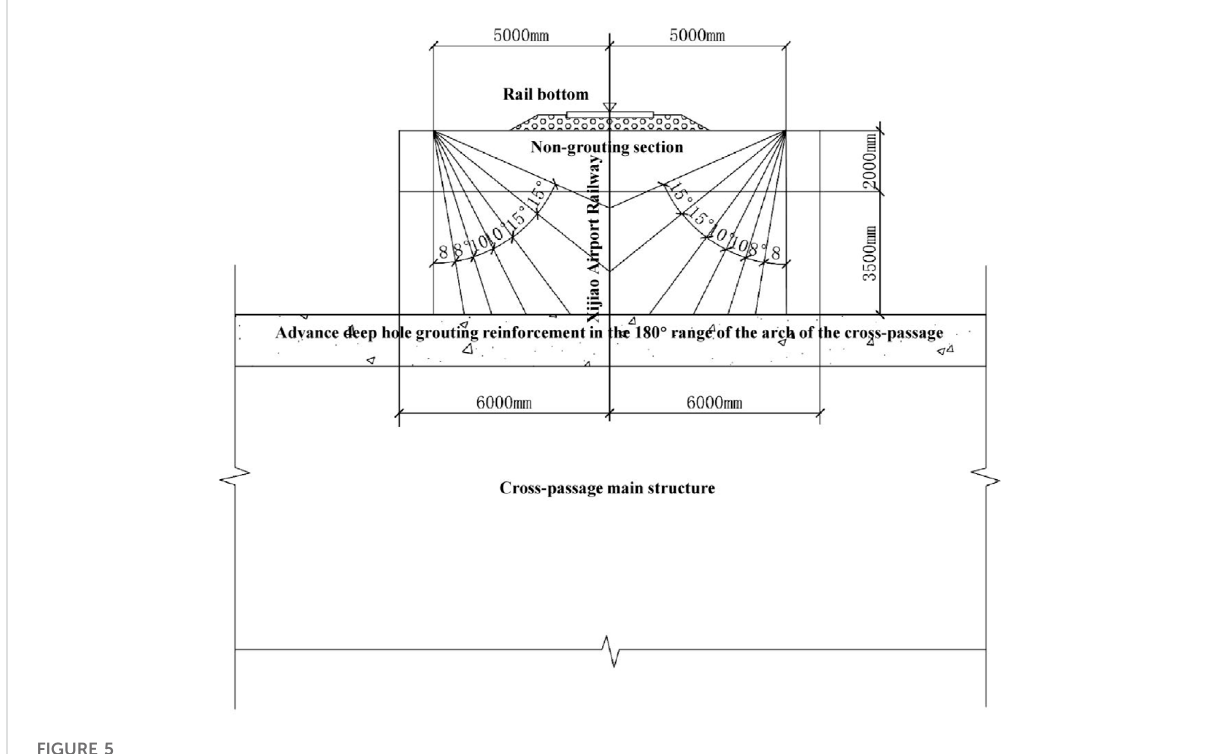
FIGURE 5 Railway subgrade strengthening cross-section.